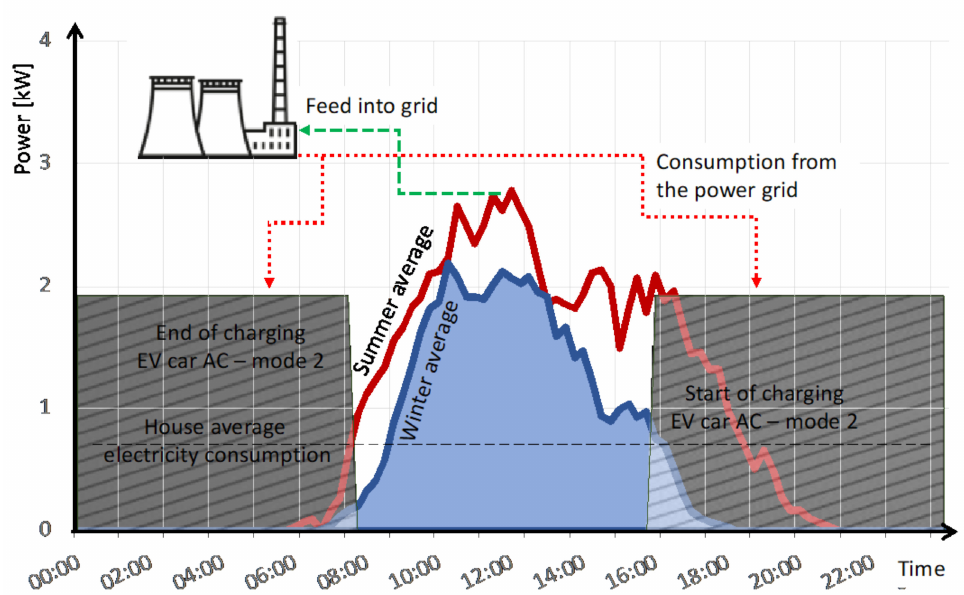
Figure 8. Electric vehicle charging scenario (using charging mode 2) in relation to the average generation of electricity from the photovoltaic installation (red—summer,